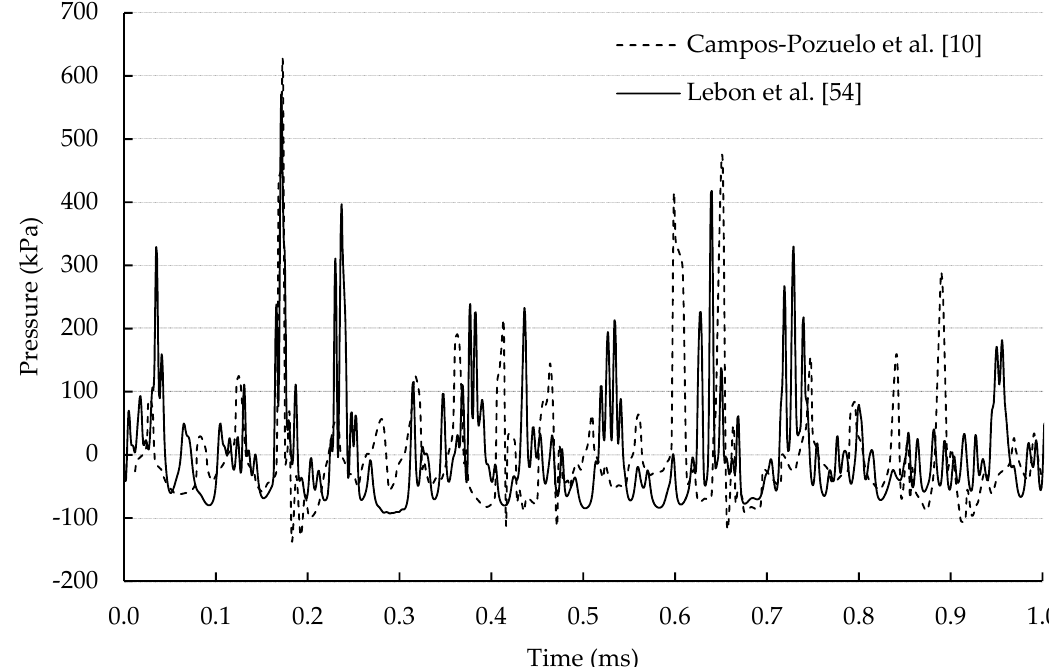
Figure 1. Validation of Caflisch approach to computing acoustic pressures [54] using experimental data from Campos-Pozuelo et al. [10].